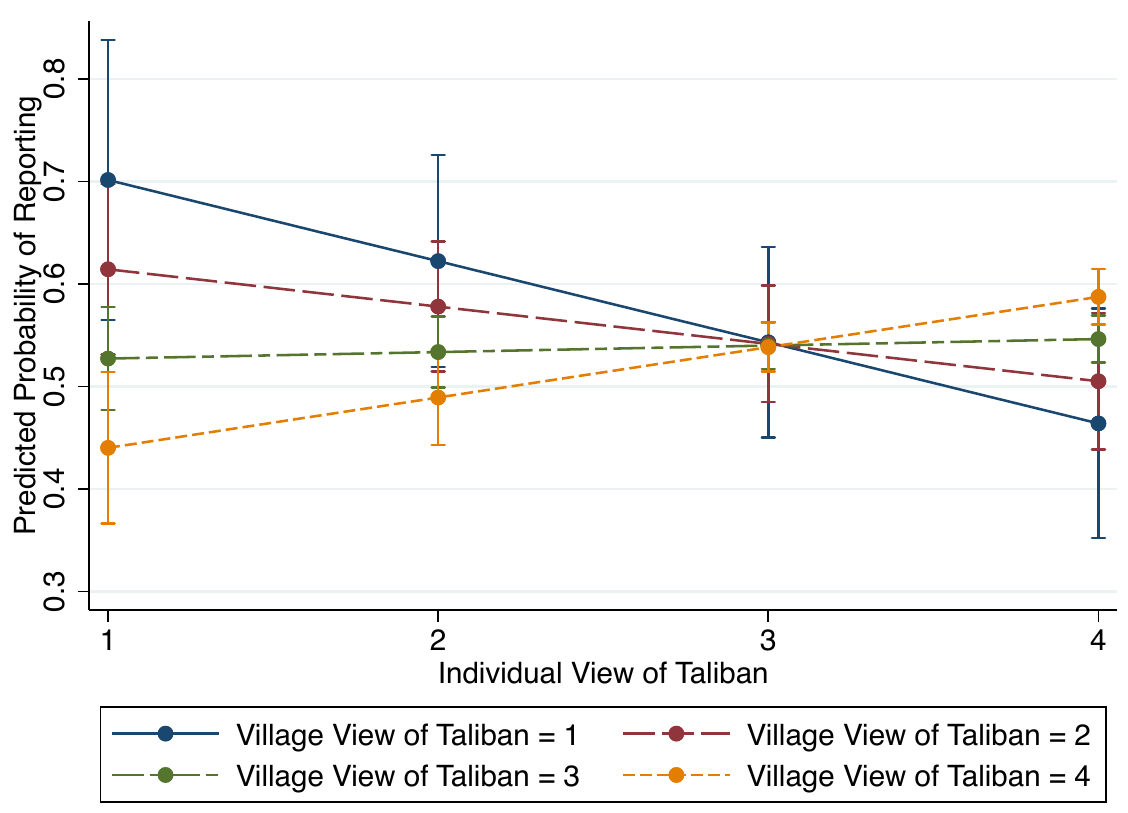
Figure 3: Predicted probability of individual and village views of the Taliban on willingness to report wrong- doing. Notes: Figure displays fitted values obtained from model (6) of Table 2 with 95 percent confidence